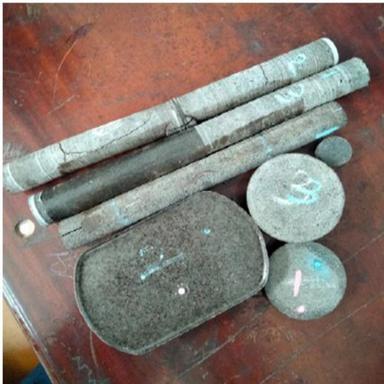
Composite material specimen.